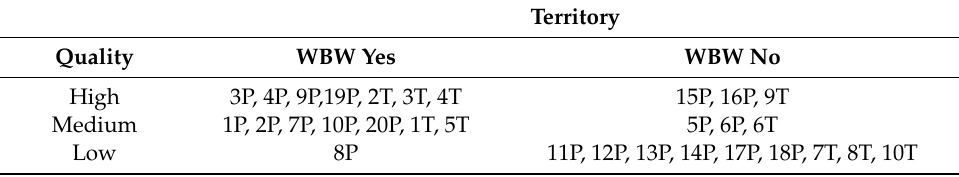
Table A1. The a priori quality of the circular plots (1–20P) and transects (1–10T) categorized as “High”, “Medium”, or “Low” based on their appearance and Bioma Forestal experts’ criteria. It is also shown whether the circular plots and transects were located in WBW territories (“WBW yes”) or no (“WBW no”).